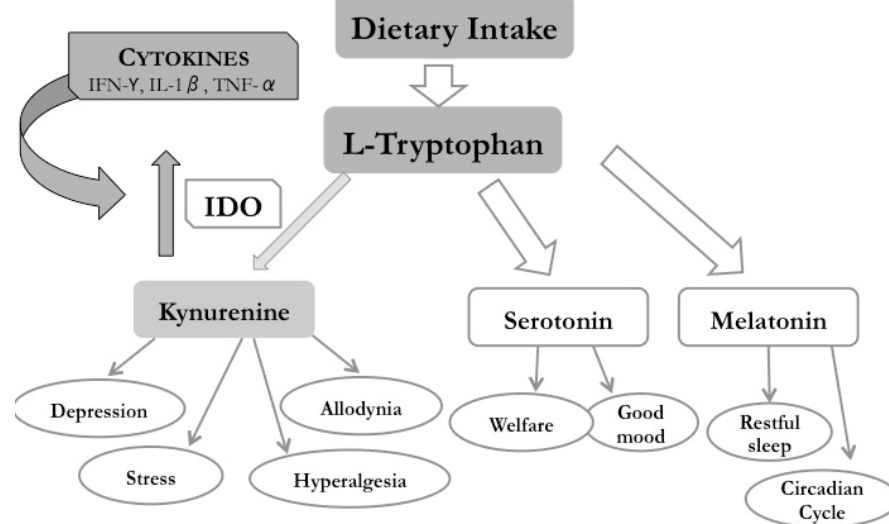
Figure 4. Sjögren’s syndrome physiopathology, considering the elevated cytokine expression activation of the kynurenine pathway (KP) and its implications in the pain and mood symptoms dissociated with the signs of SS disease. The light thick gray arrows indicate the pathway to obtain L-tryptophan to produce serotonin and melatonin and the dark gray arrow indicate the catabolic pathway of the L-tryptophan and its relationship with inflammatory cytokines. The thin gray arrows indicate the clinical manifestation of different L-tryptopahn metabolite.